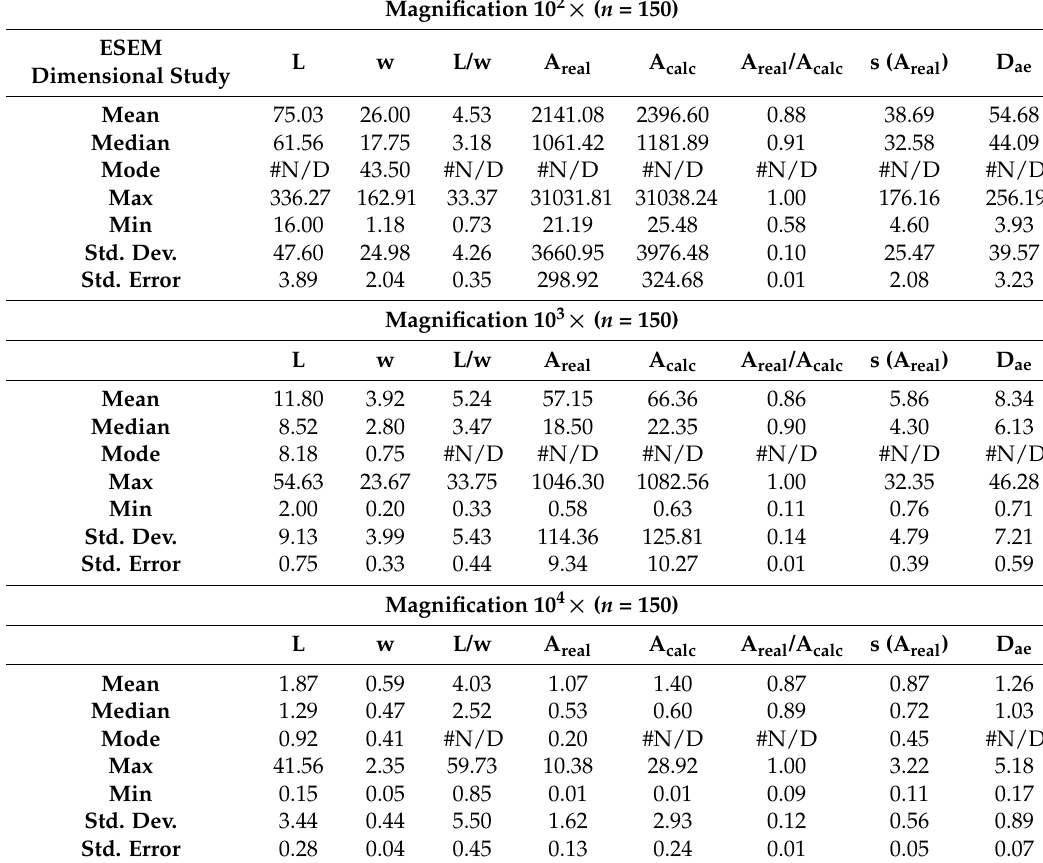
Table 3. Measurements of length ( L ), width ( w ), area ( A real ), calculated area ( A calc ), area ratio, “ s ” dimension, and aerodynamic diameters ( D ae ) for the powdered sample ( before the dissolution experiment) at different